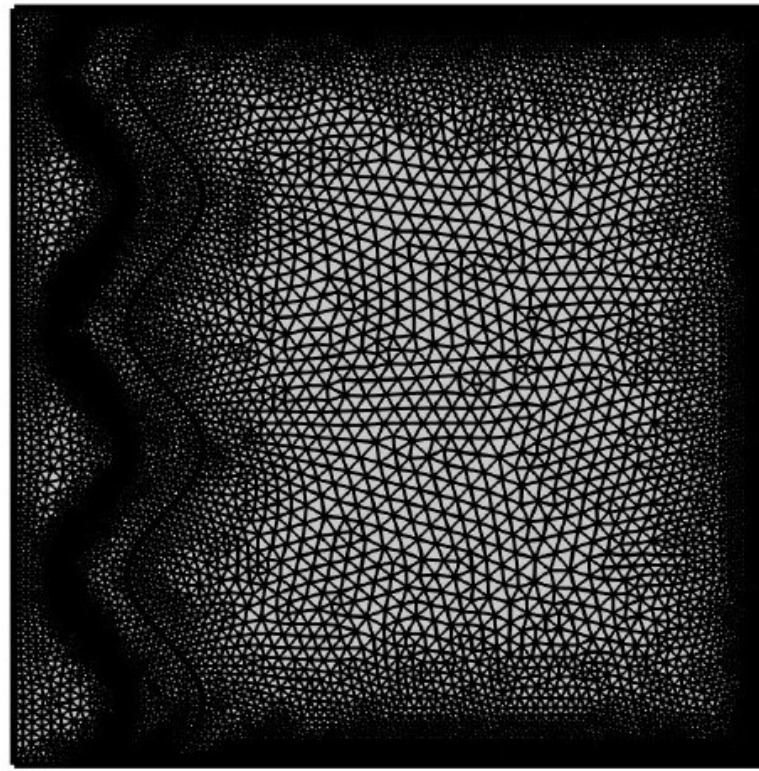
Figure 2. Coarsest mesh designed for the computational